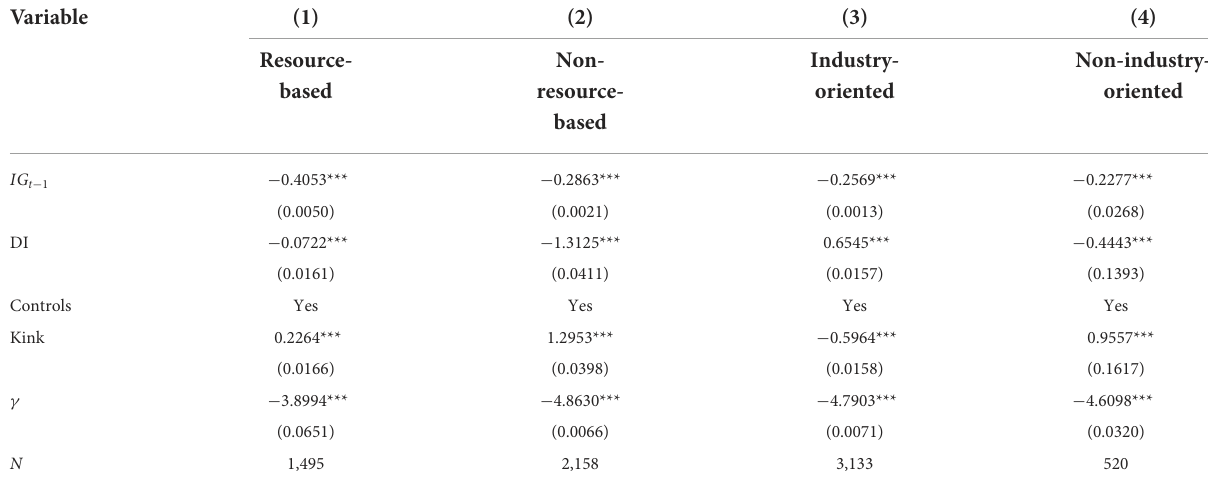
TABLE 4 Heterogeneous effect